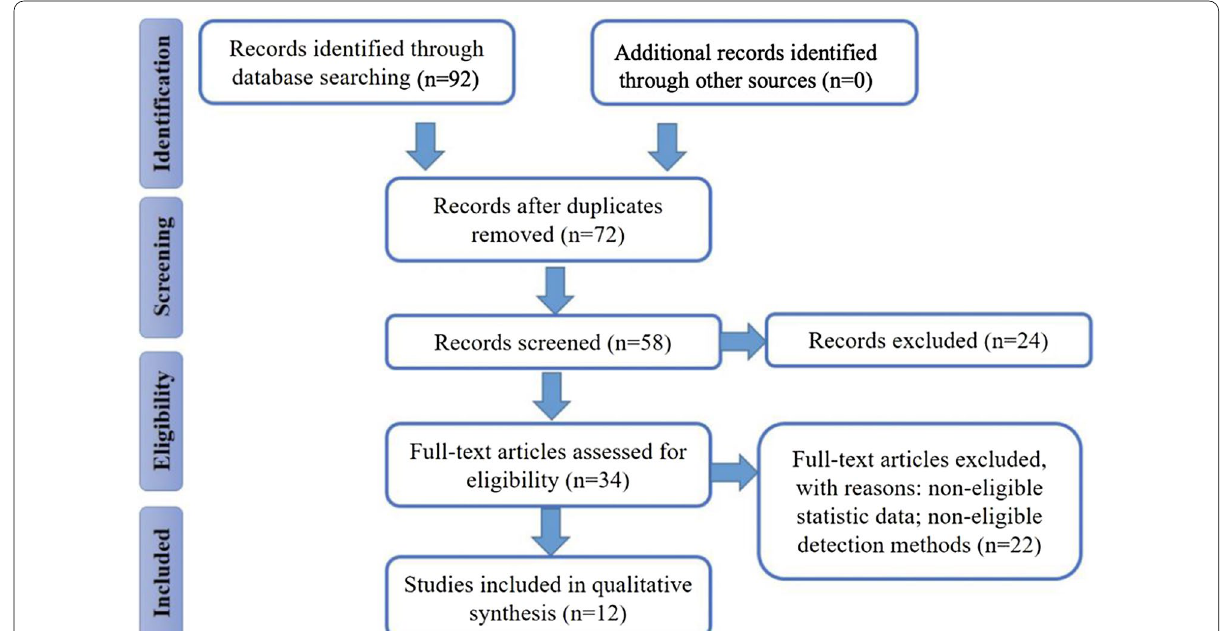
Fig. 1 Flow chart of the study search and